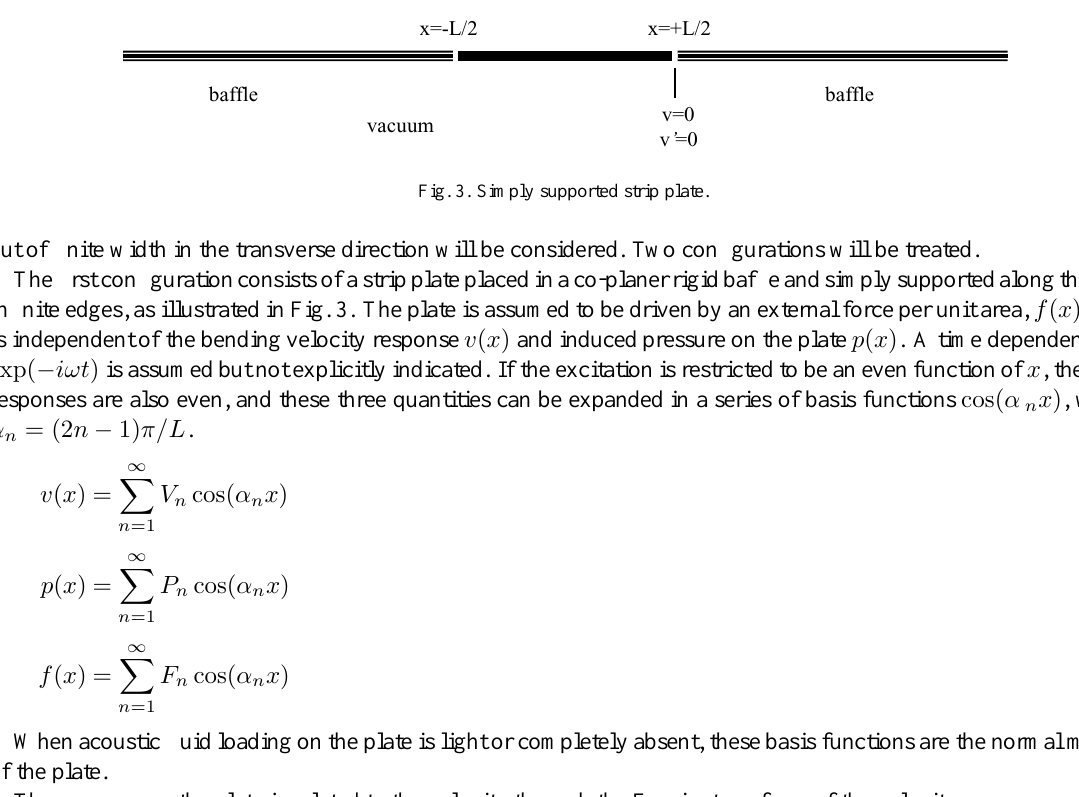
Fig. 2. Radiation efficiencies for infinite plate.